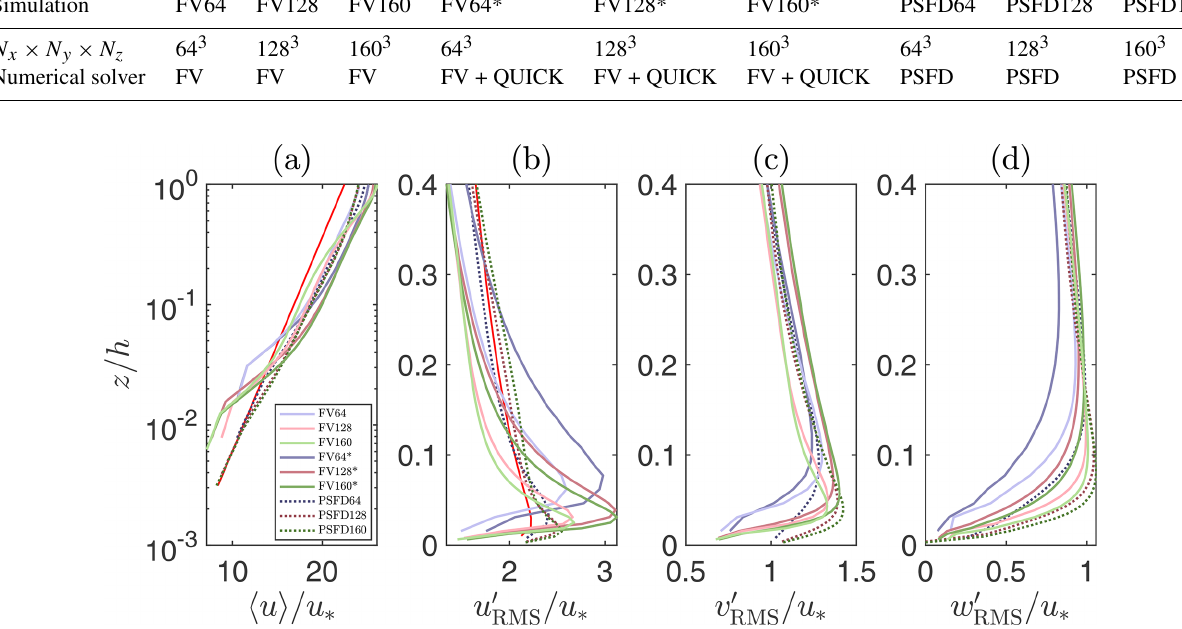
/u ∗ (b) , cross-stream velocity RMS RMS